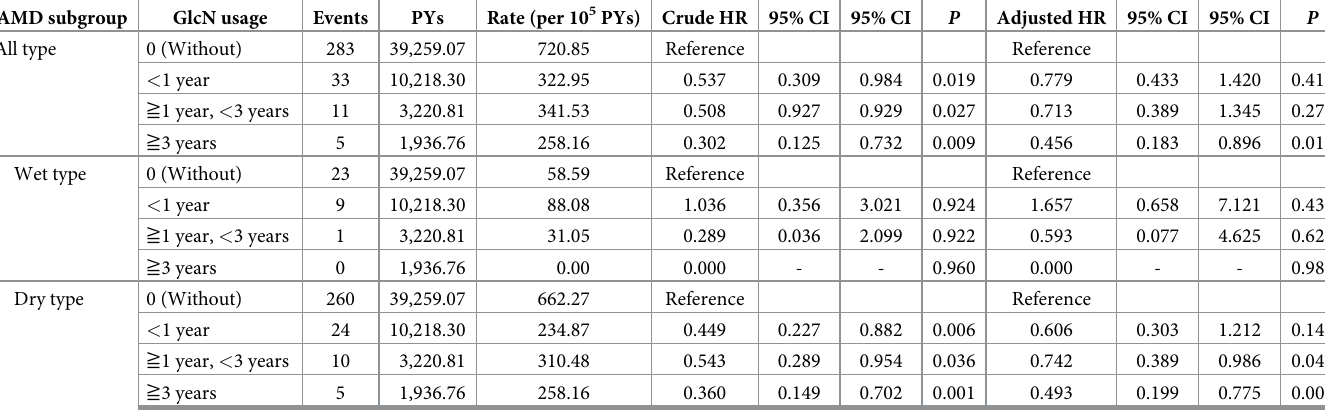
Table 5. Association between the duration of GlcN use and the development of AMD. AMD subgroup GlcN